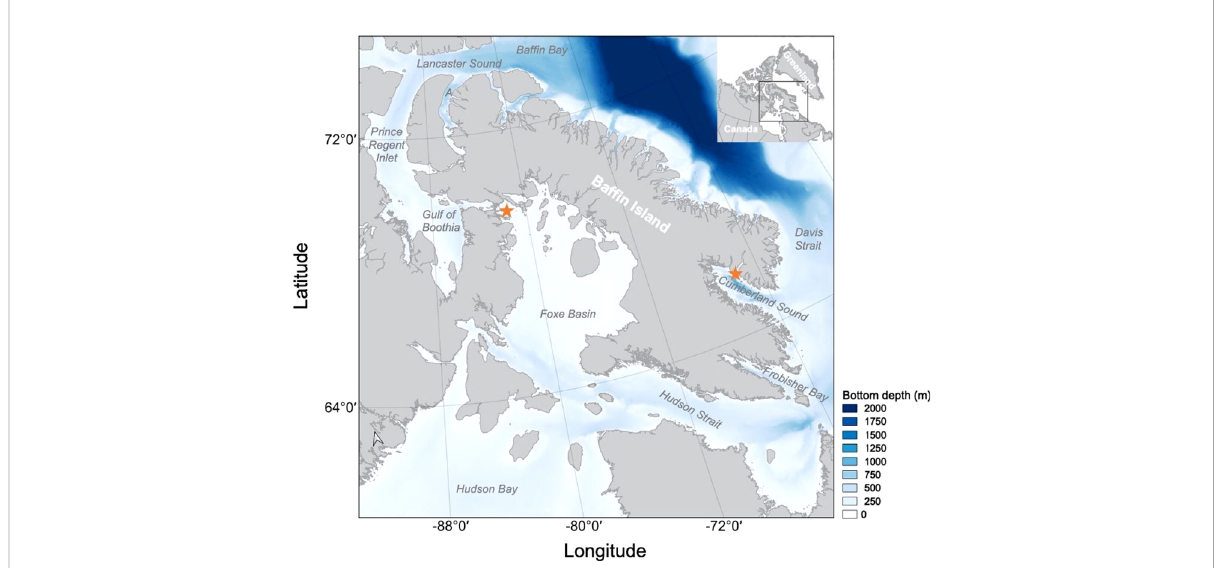
FIGURE 1 Study area for Eastern Canada-West Greenland bowhead whales tagged in Foxe Basin and Cumberland Sound Nunavut with bathymetric data indicating the depth of the sea bottom ranging from 0 m (white) to 2000 m (dark blue). Regions of interest (Hudson Bay, Hudson Strait, Foxe Basin, Gulf of Boothia/Prince Regent Inlet, Admiralty Inlet, Cumberland Sound and Frobisher Bay) are indicated with ‘ A ’ representing Admiralty Inlet. Tagging locations off Igloolik (Foxe Basin) and Pangnirtung (Cumberland Sound) are indicated ( ★ ). QGIS 3.10 (QGIS Development Team, 2018) and General Bathymetric Chart of the Oceans (GEBCO) global 453 terrain model for ocean and land (GEBCO Compilation Group, 2021) was used to construct this